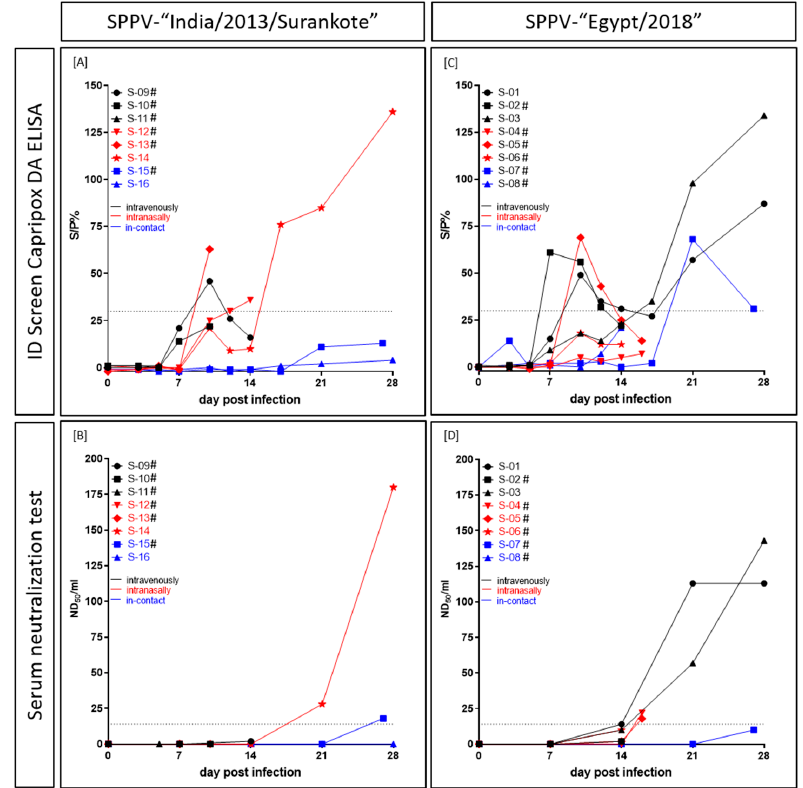
Figure 5. Serological response of sheep experimentally infected with ( A , B ) SPPV-“India / 2013 / Surankote” and ( C , D ) SPPV-“Egypt / 2018”, respectively. For serological analyses, ( A , C ) the DA ELISA and ( B , D ) the SNT were performed. In the ELISA, an S / P% ratio ≥ 30 was defined positive, and in the SNT, end of the